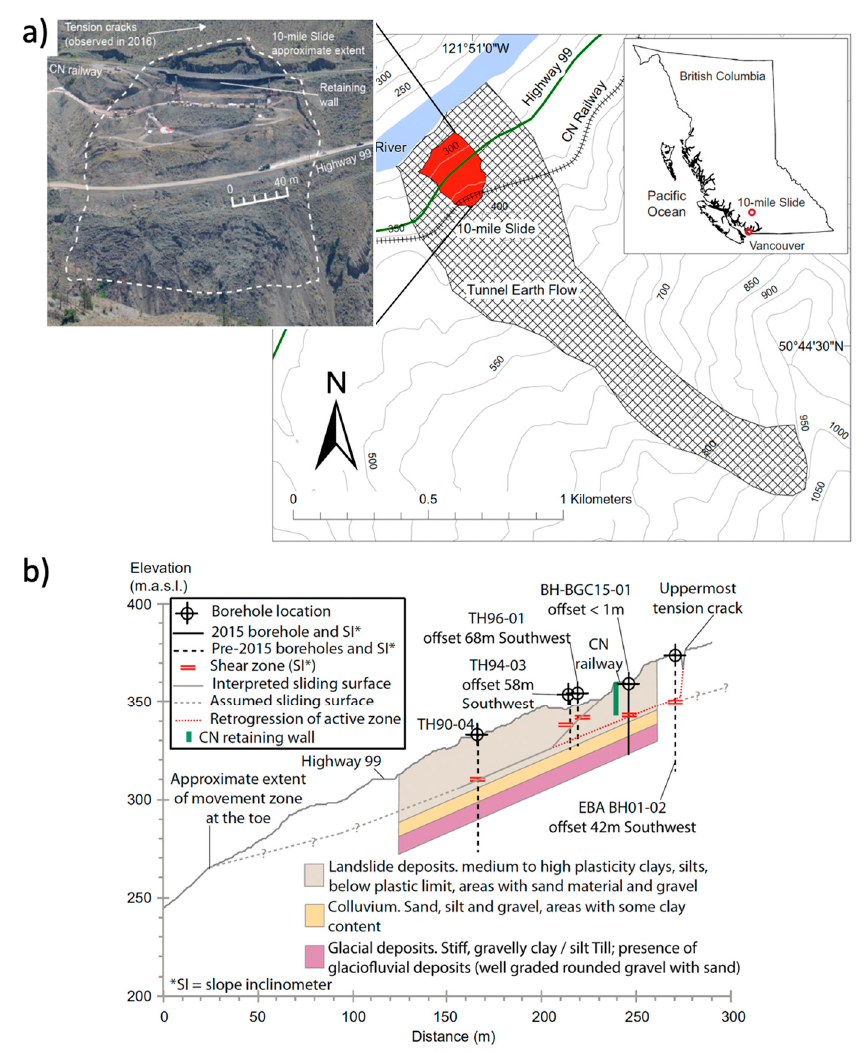
Figure 6. Location and front view of the 10-Mile Slide ( a ). Sketch of typical section and stratigraphy of the landslide ( b ) After [39].